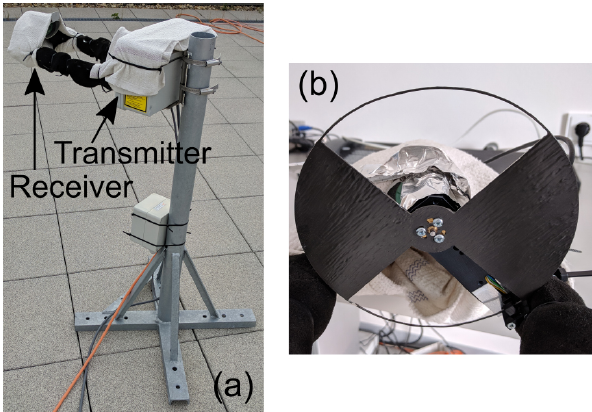
Figure 2. The laser precipitation monitor (LPM) at the Radiome- ter Physics GmbH (RPG) site (a) . Metal surfaces close to the laser beam are covered with spongy and/or cotton material to mitigate splashing. The chopper wheel (b) was mounted on side of the LPM detector to test the data transmission rate (see text for